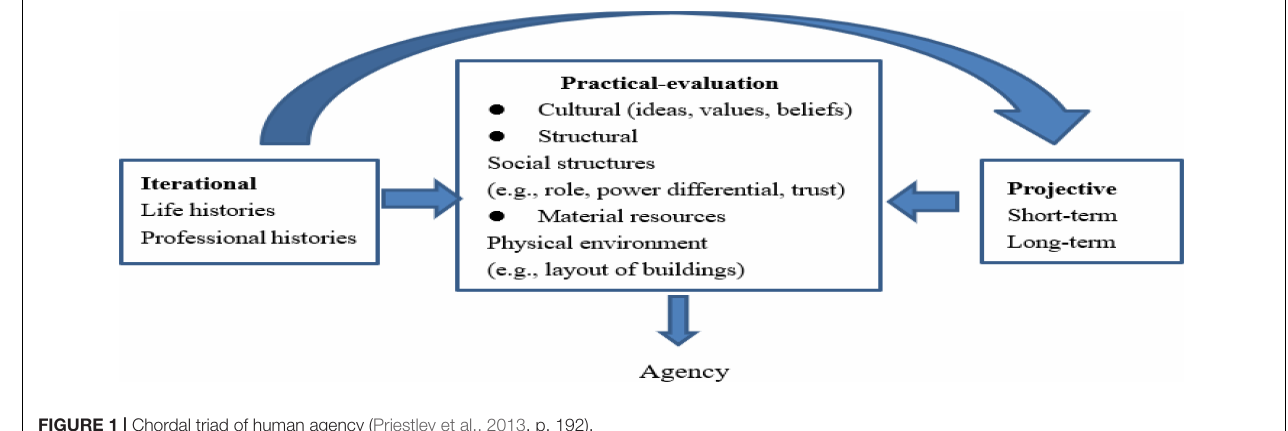
FIGURE 1 | Chordal triad of human agency (Priestley et al., 2013, p. 192).